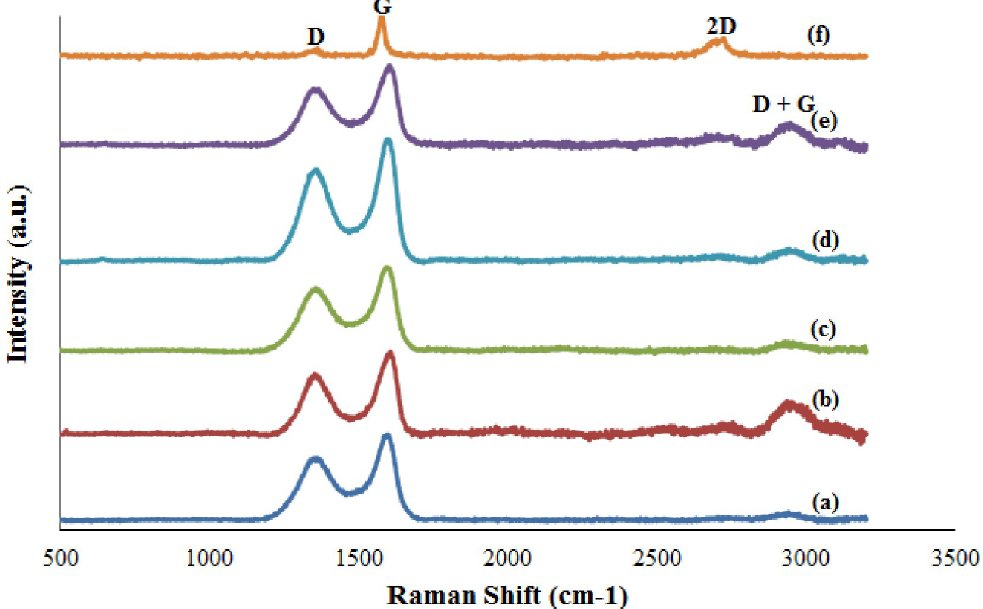
Fig 6. Raman spectra of (a) GO20, (b) GO40, (c) GO60, (d) GO72, (e) GO80, and (f)